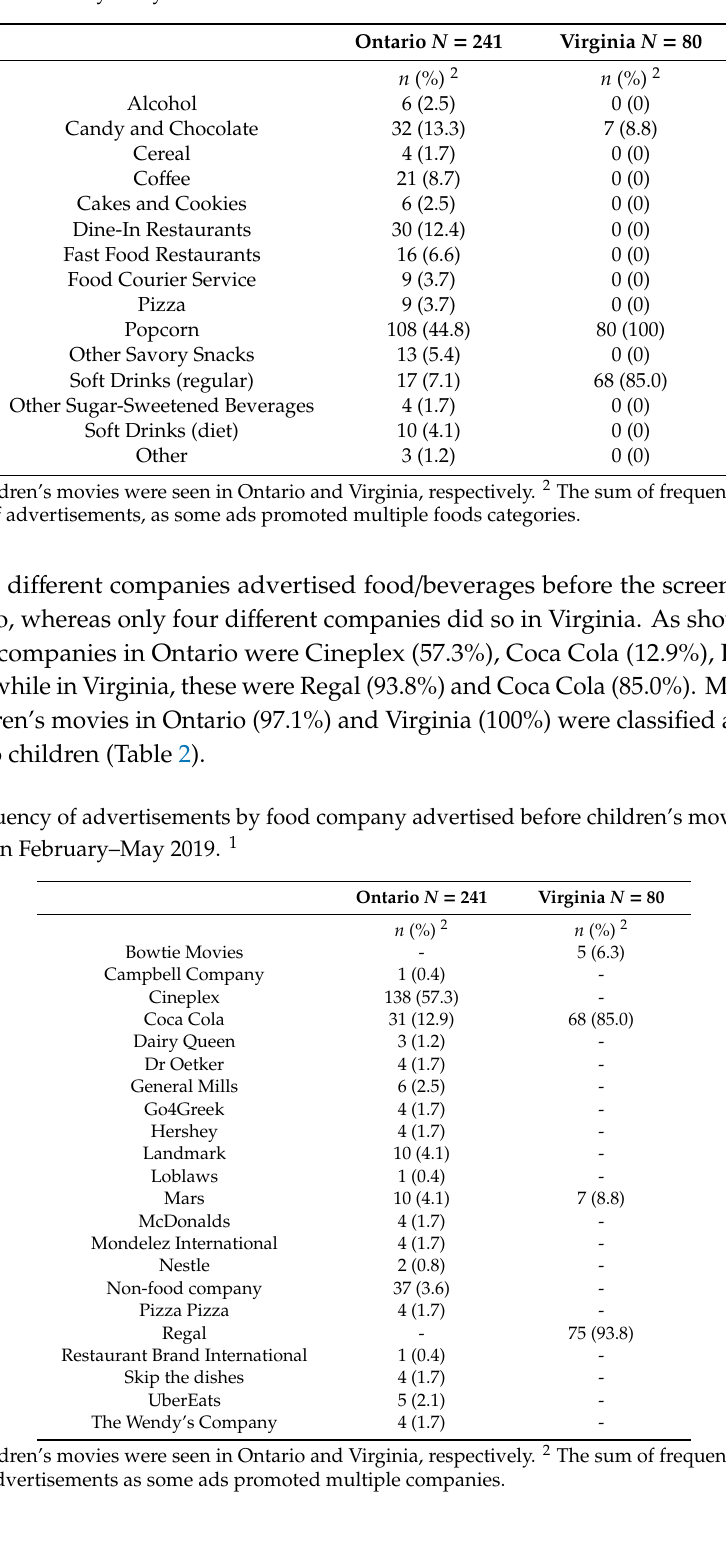
Table 3. Frequency of advertisements by food category advertised before children’s movies in Ontario